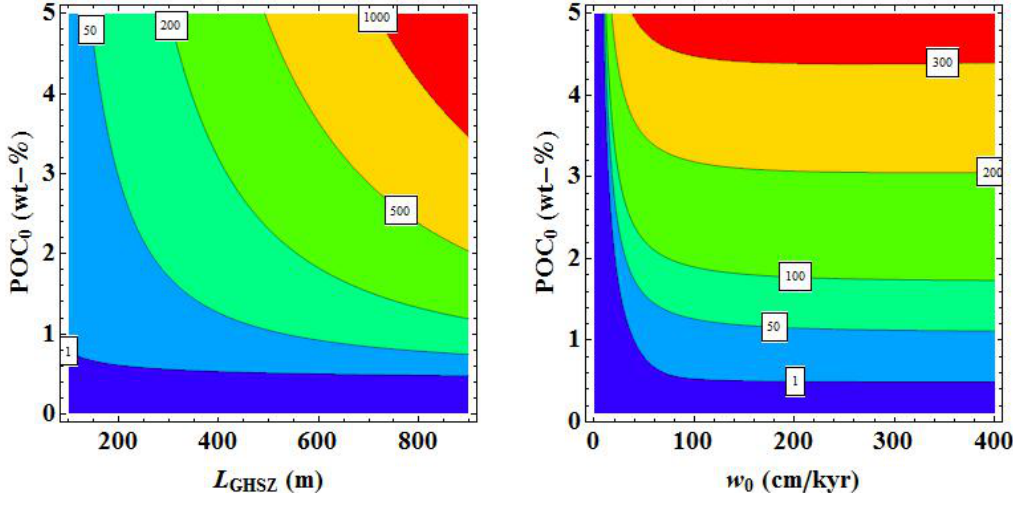
Figure 19. Controls on gas hydrate accumulation as predicted by the transfer function [Equation (31)]. The contour lines indicate gas hydrate inventories (GHI) in kg C m − 2 . The = 100 cm kyr − 1 while the contour plot contour plot on the left hand side is calculated for w 0 = 400 on the right shows the results for L GHSZ